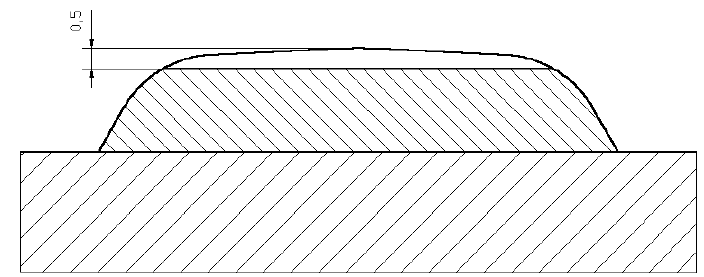
Figure 13. Preparation for hardness testing.